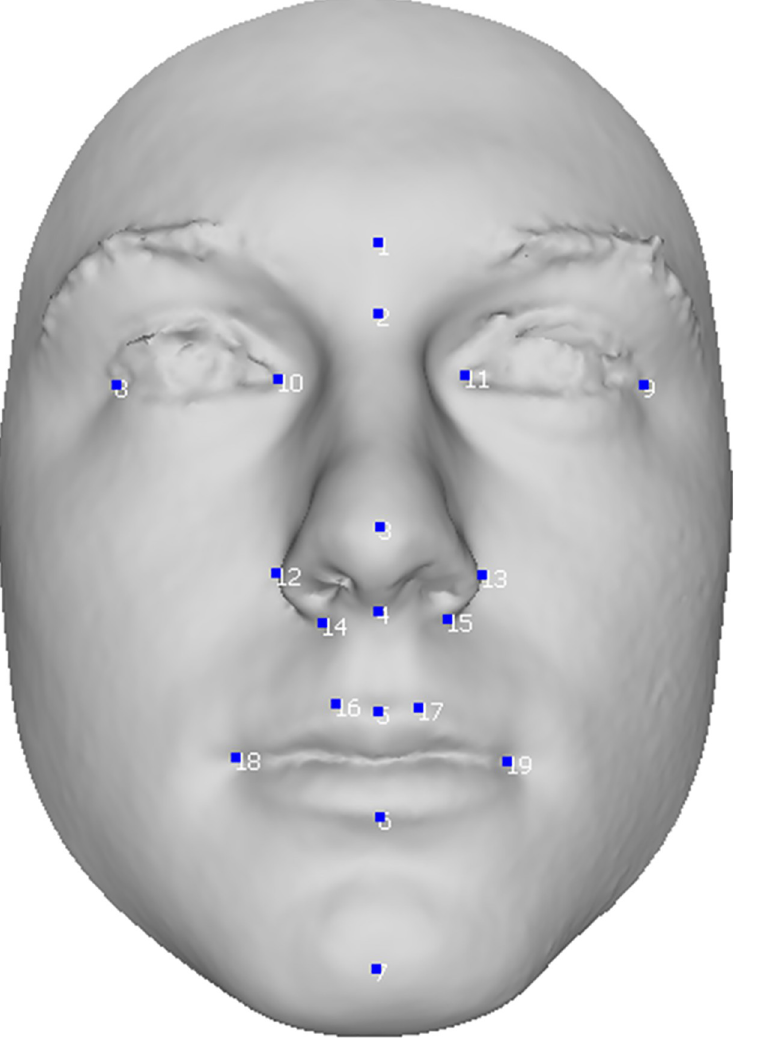
Fig 2. The position of the 19 manual landmarks used for mapping